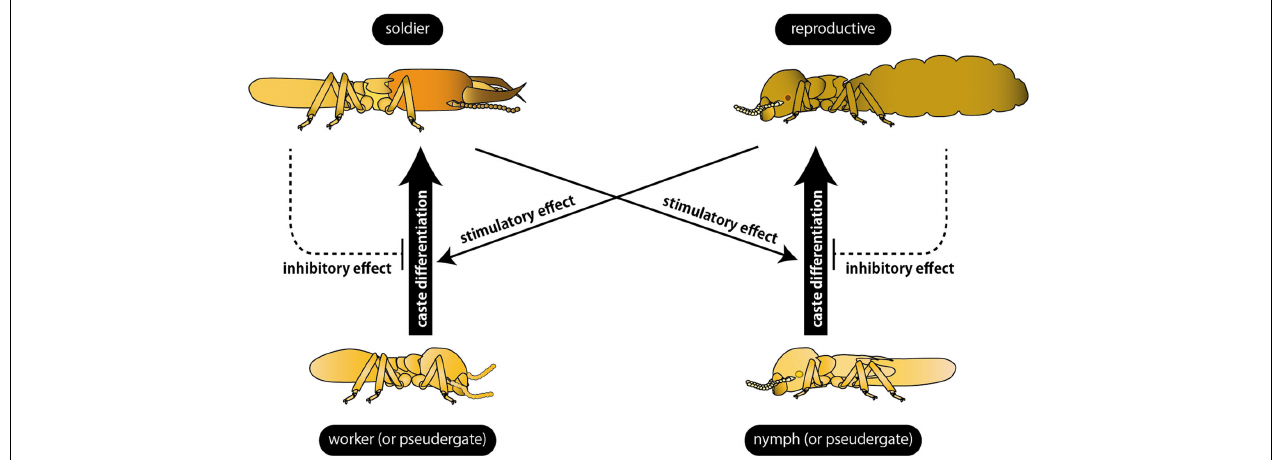
FIGURE 2 | Summary of the regulation of caste differentiation by social interactions. Differentiation into reproductives and soldiers (bold arrows) are stimulated by different castes (thin arrows) and inhibited by